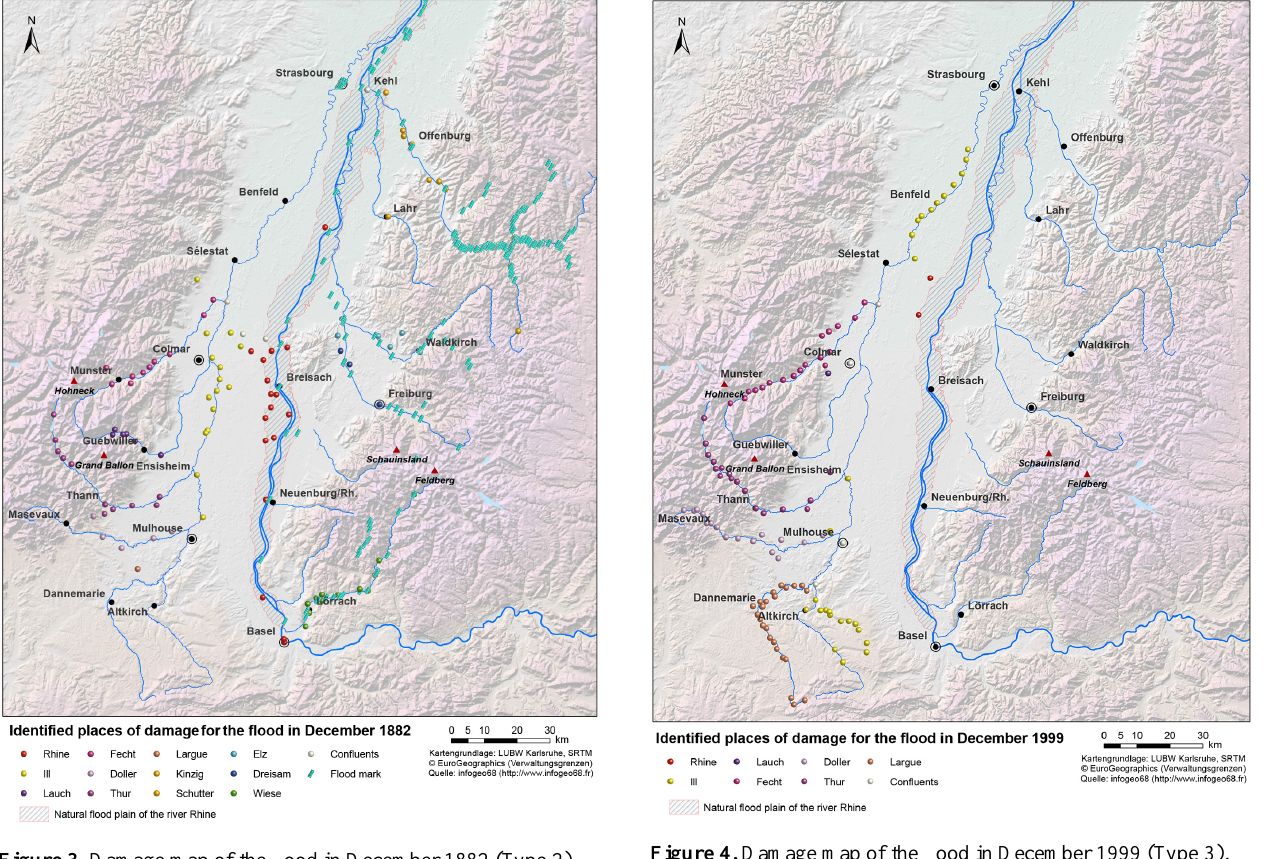
Figure 3. Damage map of the flood in December 1882 (Type 2). Figure 4. Damage map of the flood in December 1999 (Type